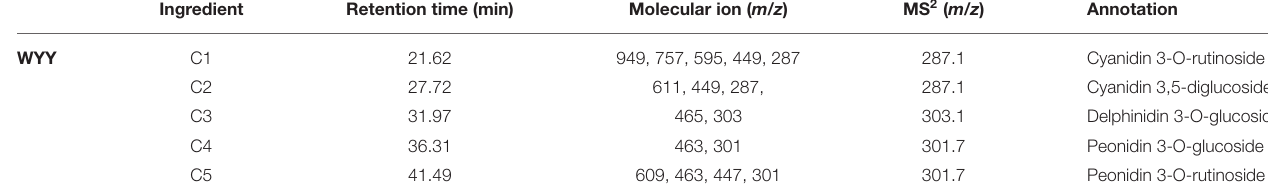
TABLE 2 | Structure identification of anthocyanidins in WYY.